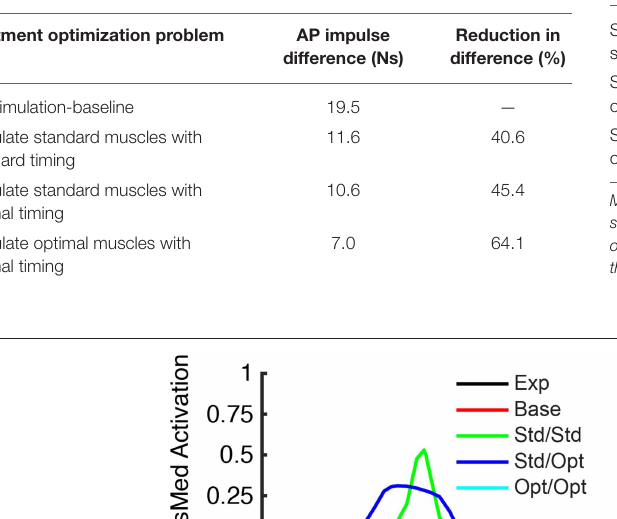
TABLE 6 | Difference in anterior-posterior (AP) force impulse between the two legs for the baseline optimization with no muscle stimulation and the three FastFES treatment optimizations, along with percent reduction in AP force impulse difference relative to baseline.